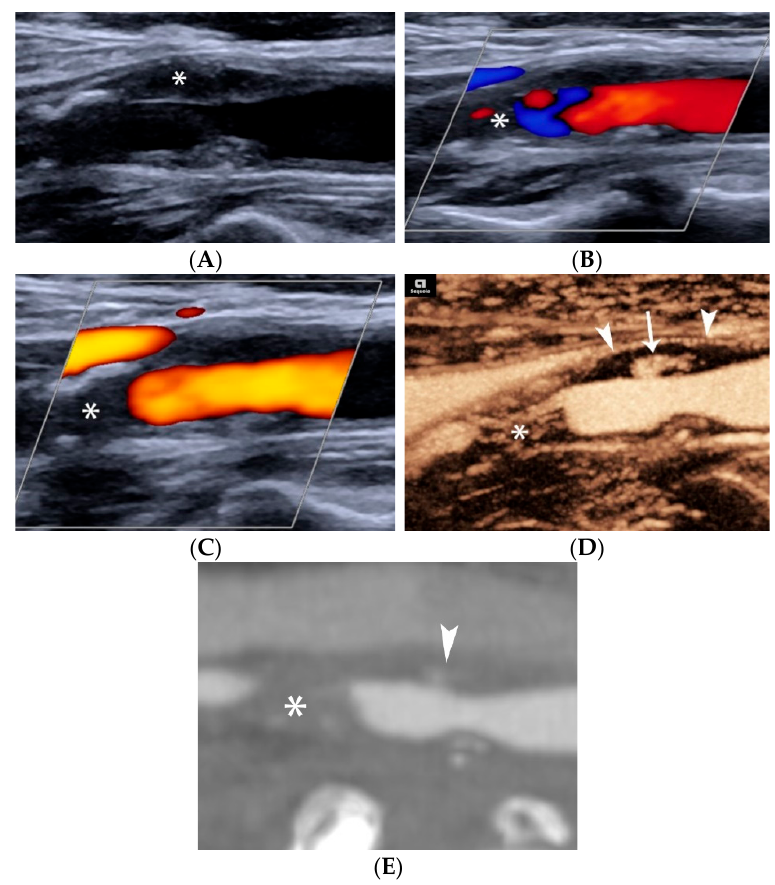
Figure 8. A 60-year-old man with stroke. B-mode ( A ) showing an elongated hypoechoic plaque in the near carotid wall (arrowheads). Note the echogenic thin fibrous cap and the distal calcification (asterisk). Colour ( B ) and power Doppler ( C ) images showing a smooth surface with limited distal flow signals, raising suspicion of occlusion (asterisk). Maximum-Intensity-Projection (MIP) CEUS image ( D ) showing a pre-occlusive stenosis (asterisk) with patent distal lumen, along with a small superficial ulceration (arrow) and adventitial neovascularization (arrowheads). CTA ( E ) confirming the presence of ulceration (arrowhead) and pre-occlusive stenosis (asterisk). Note the blurred appearance of ulcer outline owing to the lower spatial resolution of CTA compared to CEUS.